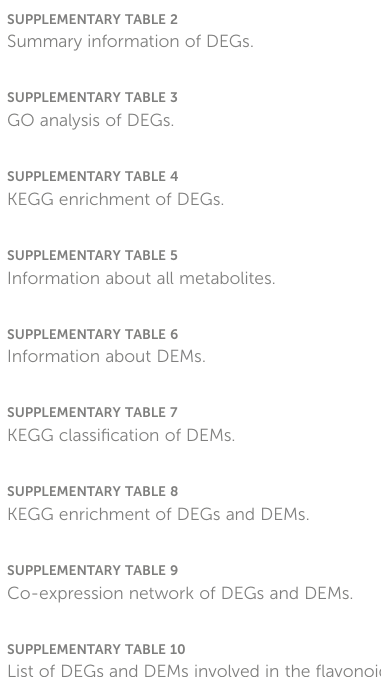
SUPPLEMENTARY TABLE 1 Statistics regarding transcriptome sequencing results.